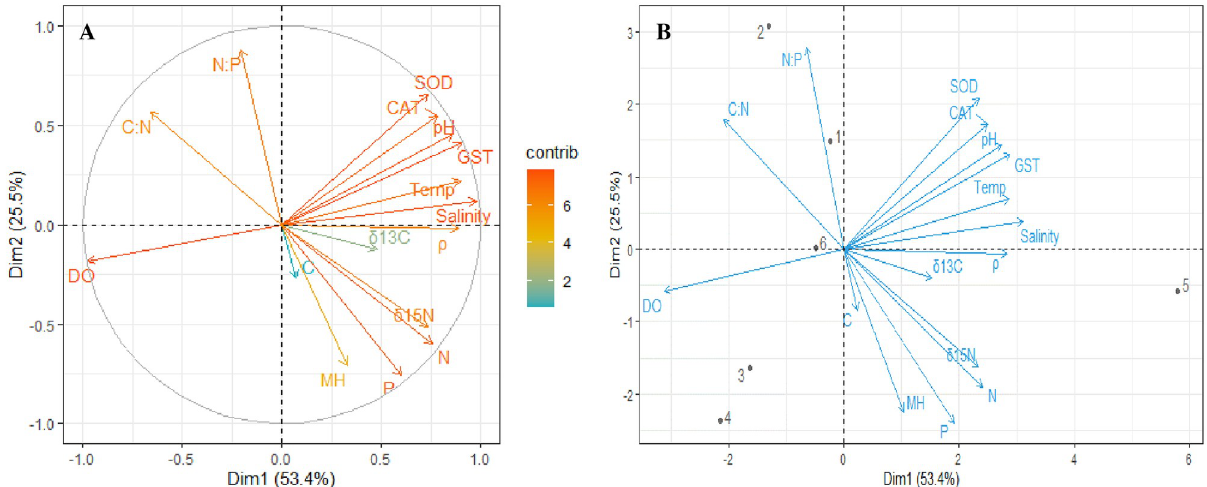
Fig 4. The (A) contribution plot and (B) biplot of principal component analysis in which the relationships among nutrients, physicochemical parameters, antioxidants and mangrove height on the coast of the central Red Sea, Saudi Arabia, were examined. C—Total organic carbon, N— Total nitrogen, P—Total phosphorus, δ 13 C—Carbon isotope, δ 15 N—Nitrogen isotope, C:N—Carbon-Nitrogen ratio, N:P—Nitrogen-Phosphorus ratio, CAT—Catalase, GST—Glutathione S- transferase, SOD—Superoxide dismutase, DO—Dissolve oxygen, MH—Mangrove height, Temp—Temperature, ρ– Density, 1–8—Study areas (1-Al Lith, 2-South Jeddah, 3-Dahaban, 4-Thuwal, 5-Rabigh and